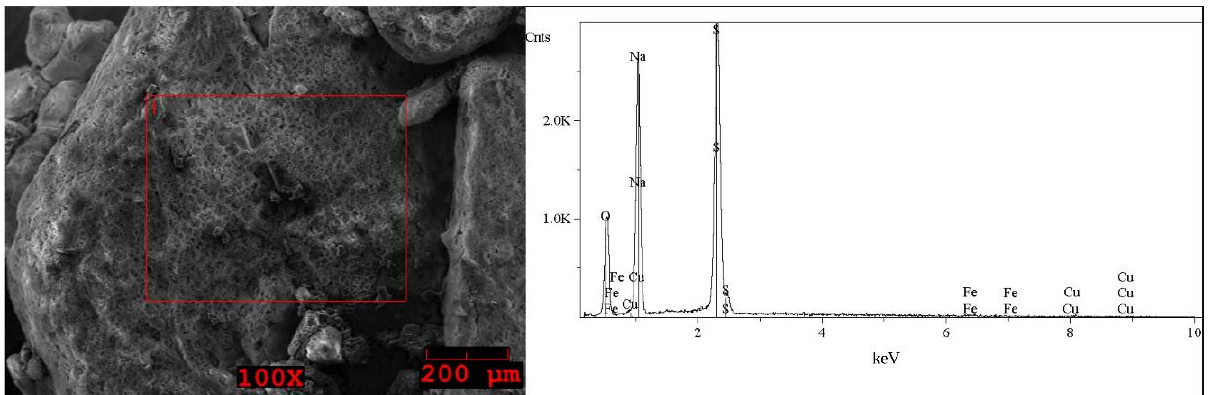
Figure 6. SEM image of the white solid phase sample precipitated out from the post-leaching solution I and EDS spectrum taken from the area marked in the image.